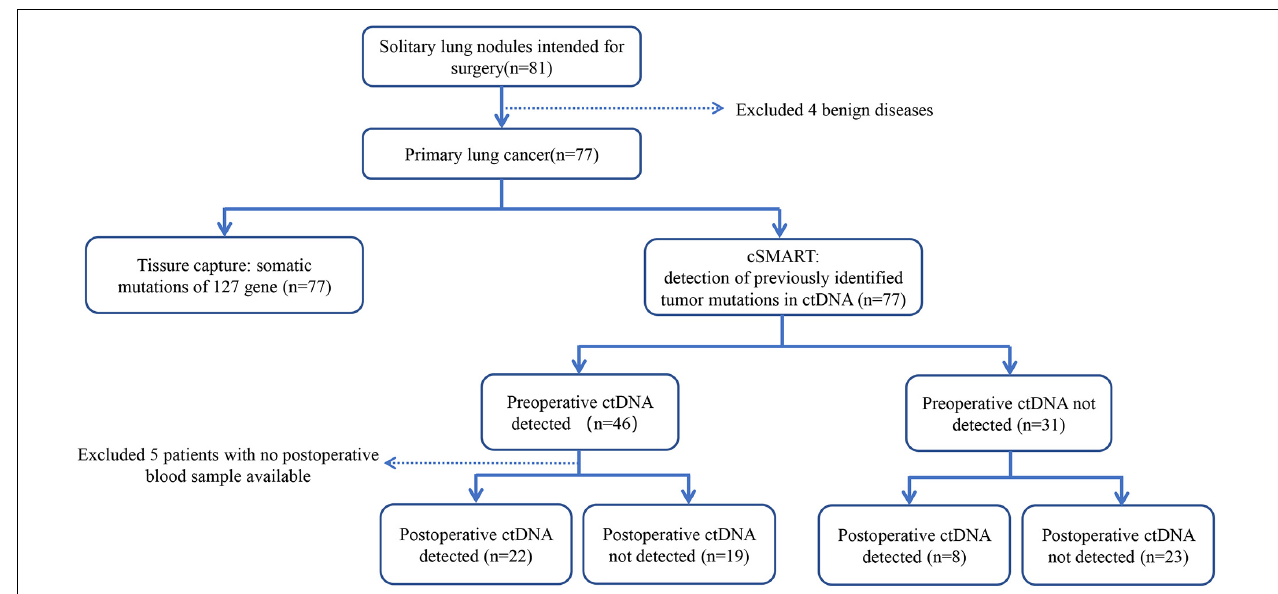
FIGURE 1 | Consort diagram of patient enrollment, specimen collection and clinical